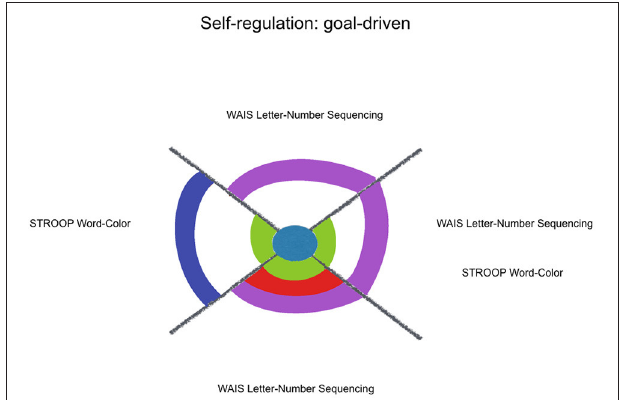
FIGURE 3 | Kindness estimation of neuropsychological performance, considering relative and joint influence of psychosocial and sociodemographic factors: goal-driven self-regulation. Legend: Significant (non-)linear models with all of their factors weighted above Pc 75 (among all the models including each of them). Kindness in blue, Social Desirability in green, Mother’s Educational Level in red, Sex in purple, Age in lilac.